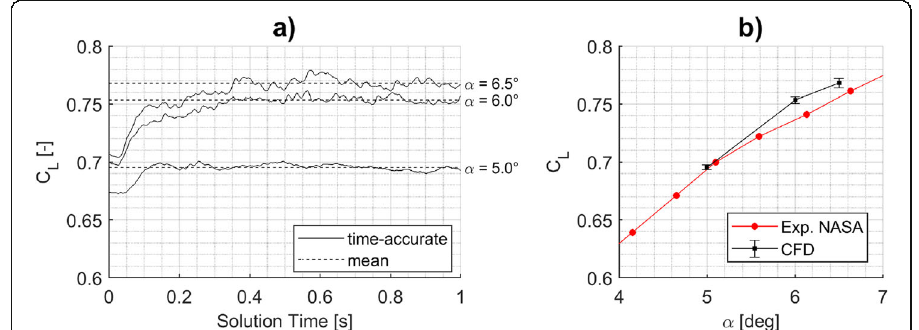
Fig. 5 Evolution of C L : a Time-accurate variation with incidence; b Comparison with